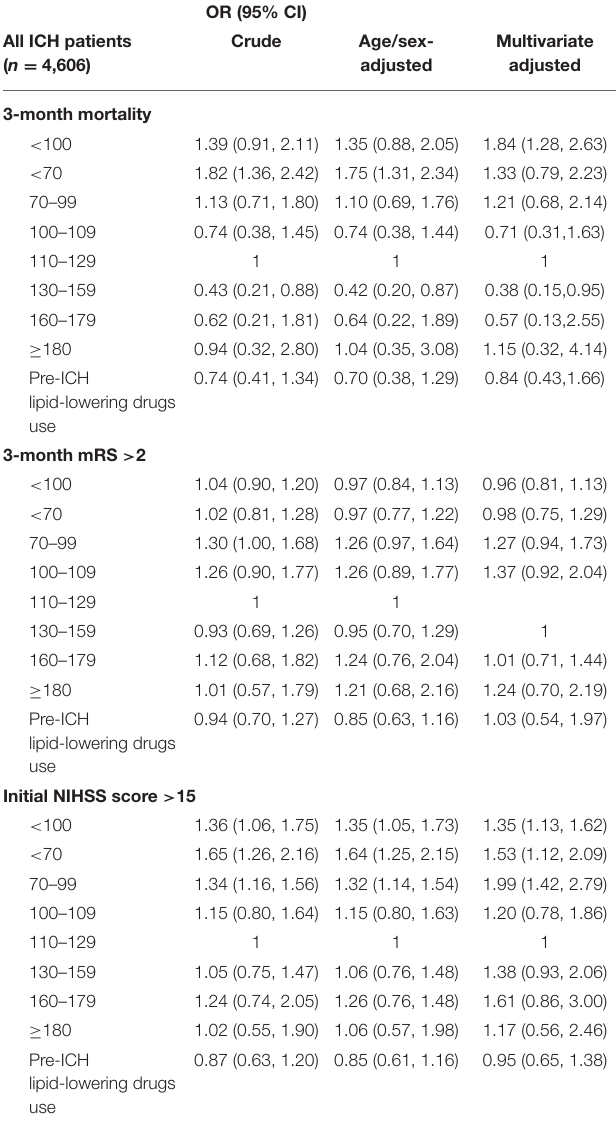
TABLE 5 | Association between initial stroke severity and 3 months outcome by LDL-C levels and pre-ICH lipid-lowering drugs use in TSR. OR (95% CI)